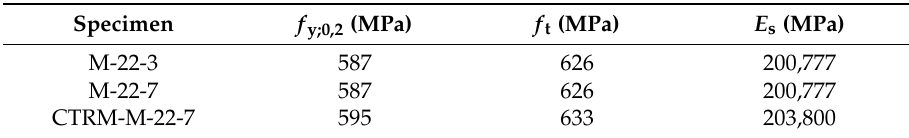
Table 5. Mechanical properties of the shear